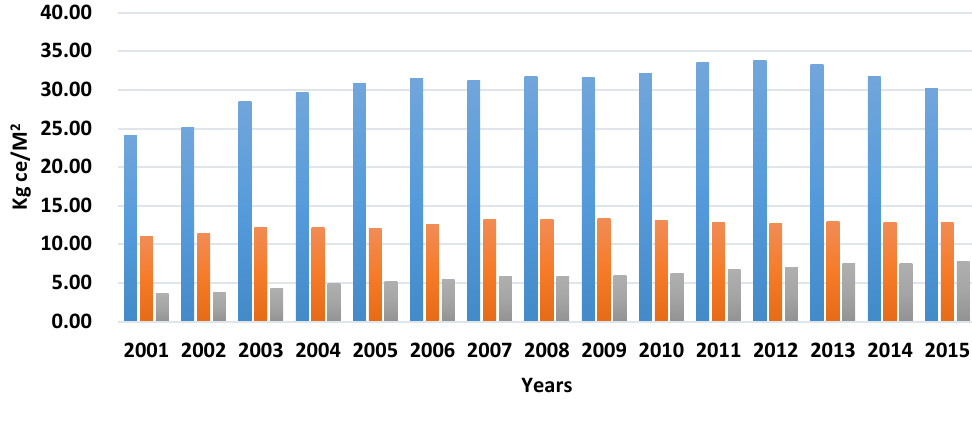
Figure 5. Energy Intensities of Three Types of Buildings in China.